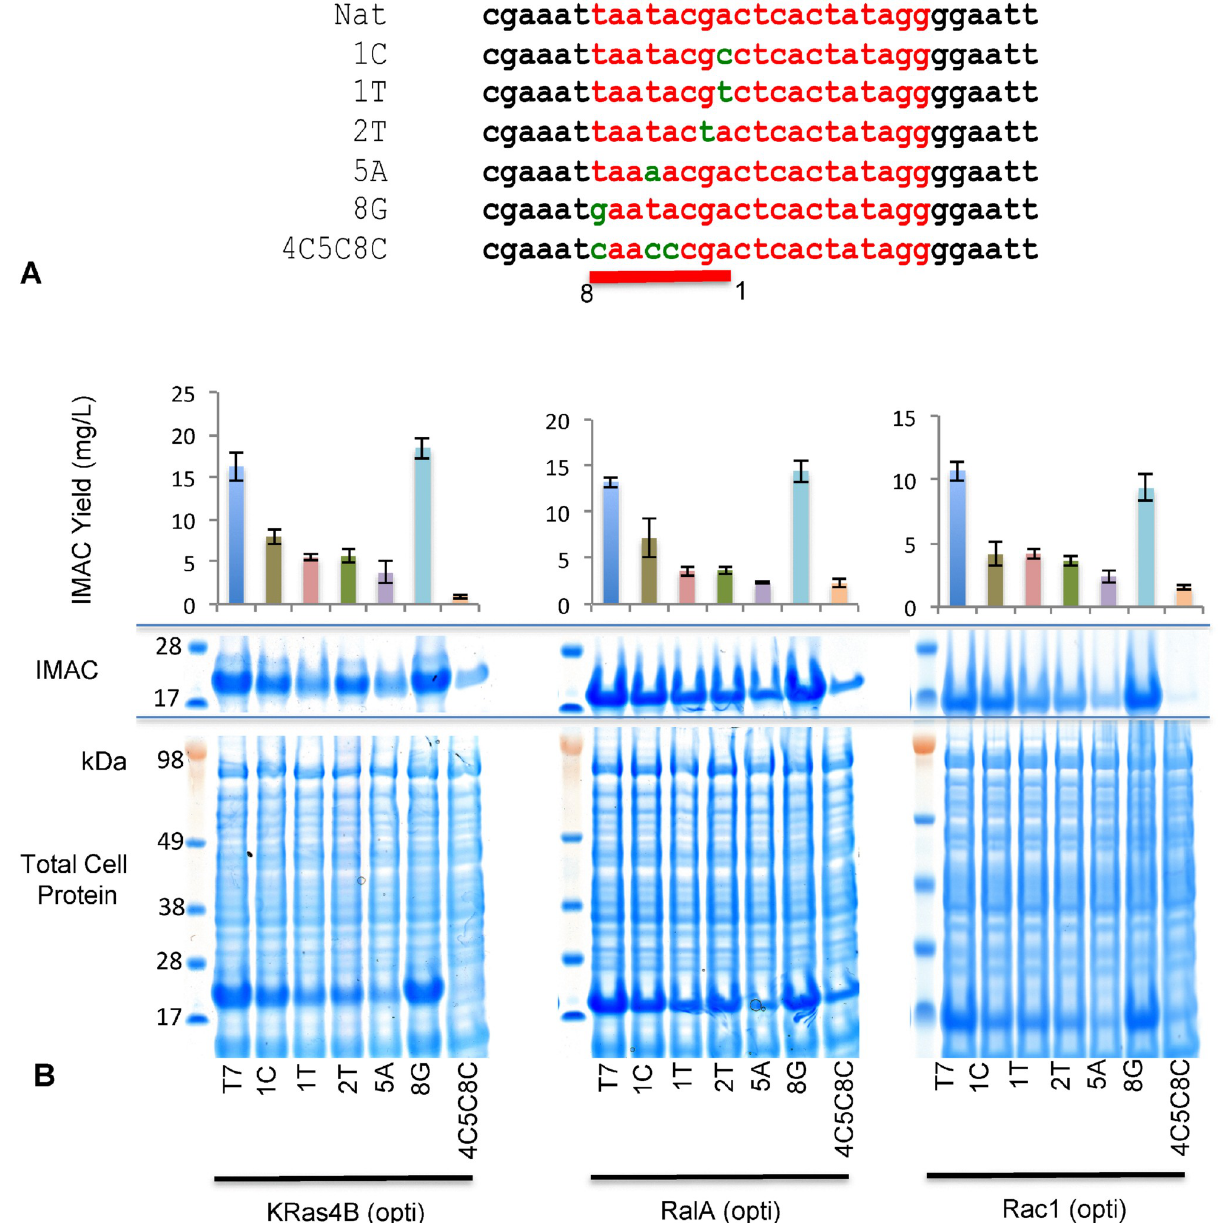
Fig 3. Solubility is not improved by altering the T7 promoter. (A) A series of attenuating point mutations, indicated from the literature, were established in the T7 promoter region of each pBDDP-SPR3 expression clone. (B) SDS-PAGE and soluble fraction IMAC output of codon optimized GTPase expression clones with degenerated the T7